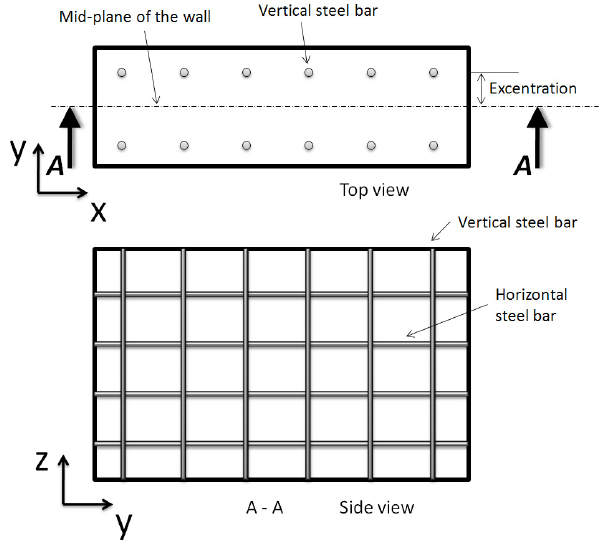
Fig. 9. Steel bar modeling. Fig. 10. FEM model of the reference